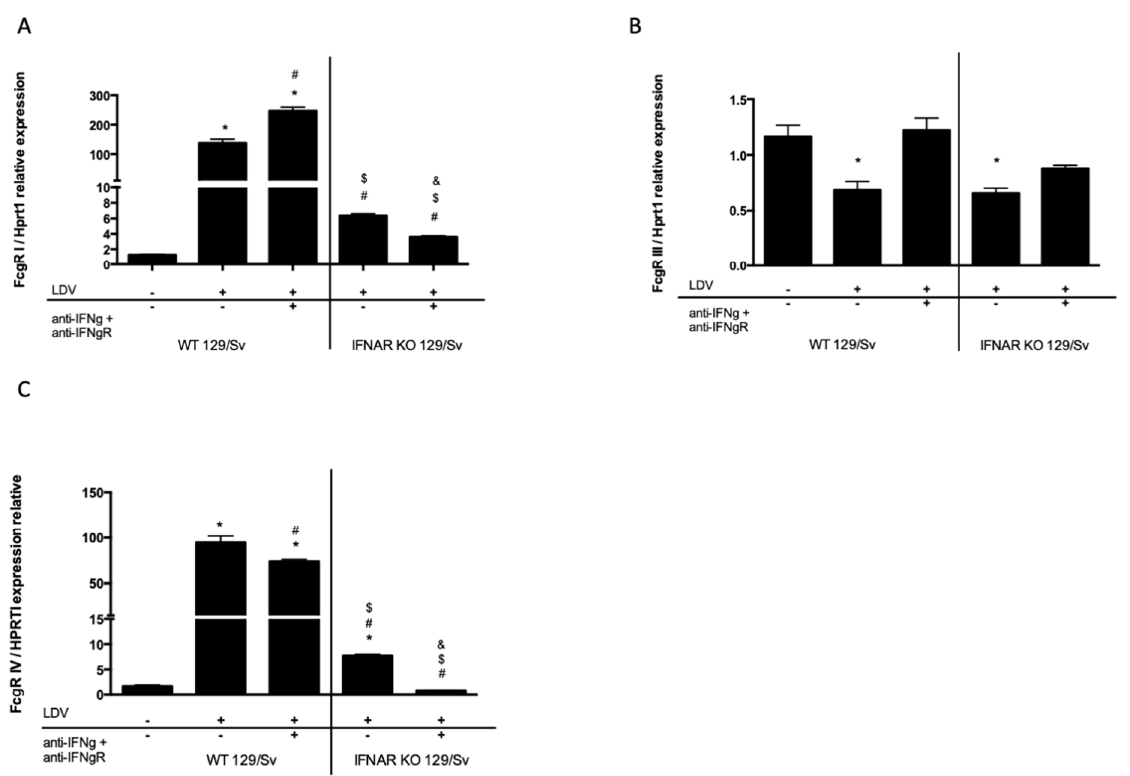
Figure 4. Role of type I and type II IFNs in Fc γ receptor expression in peritoneal macrophages of LDV-infected mice. The expressions of Fc γ R I ( A ), Fc γ R III ( B ), and Fc γ R IV ( C ) were measured by RT-qPCR in macrophages isolated from groups of 4 129/Sv or IFNAR KO mice 1 day after LDV infection. * compared to control 129/Sv; # compared to infected 129/Sv; $ compared to infected 129/Sv treated with IFN- γ and IFN- γ R-blocking antibodies. & compared to infected IFNAR KO treated with IFN- γ and IFN- γ R-blocking antibodies. The results are shown as the means ± SEM.